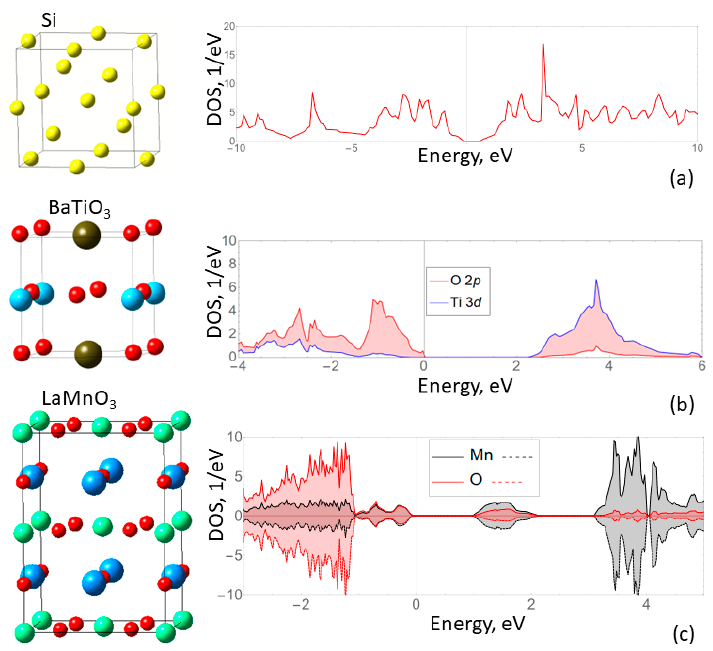
Figure 1. The unit cells of silicon ( a ) barium titanate ( b ) and LaMnO 3 ( c ), as well as the calculated DOS spectra for these compounds. The DOS spectra confirm the presence of band gaps.